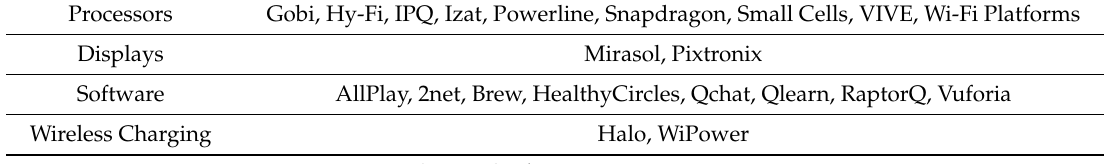
Table 1. List of Qualcomm’s